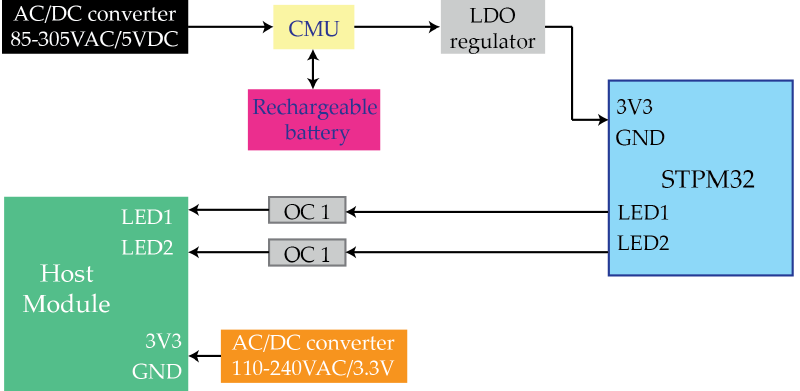
Figure 12. Interfacing board block diagram (CMU—charging management unit, OC—optocoupler, LDO regulator—low-dropout regulator).